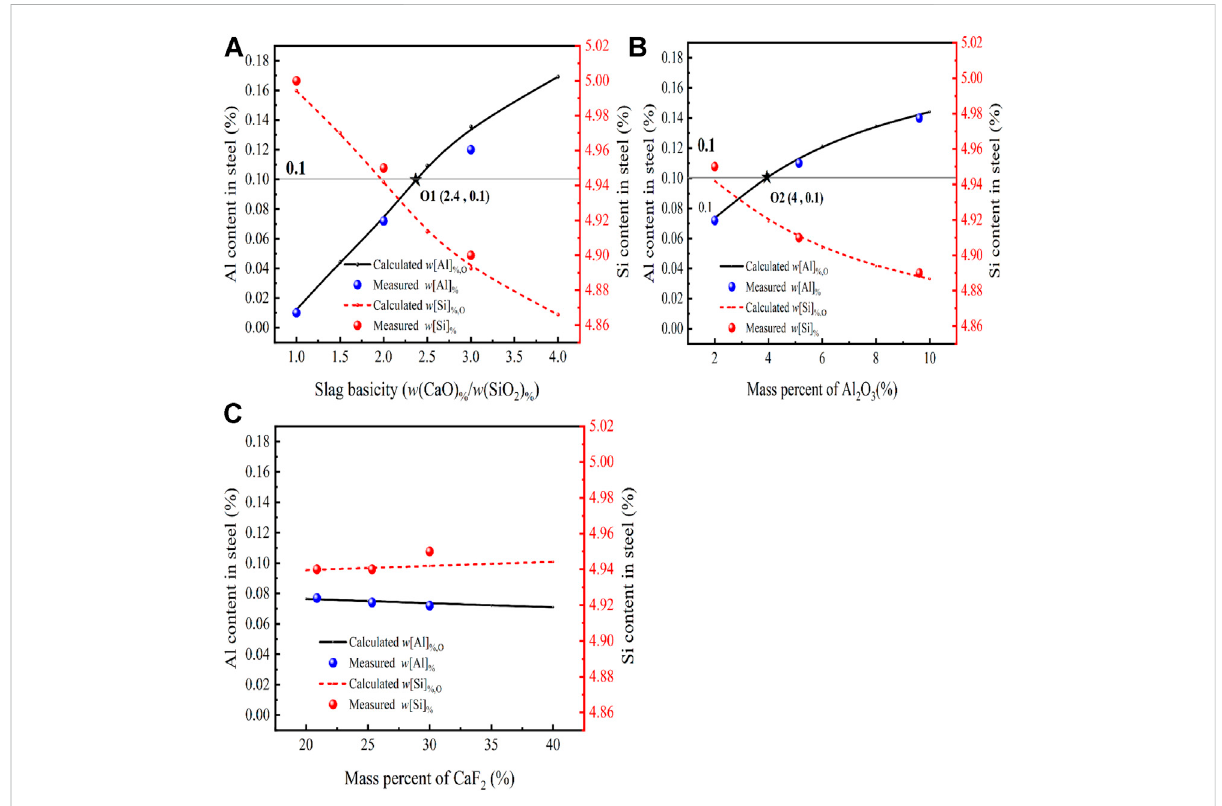
FIGURE 7 Effect of different slag compositions at 1,873 K (A) CaO, (B) Al 2 O 3 , (C) CaF 2 on the Si and Al content in steel [model predictions (lines), experimental data (dots) and the initial w[Al]% (gray